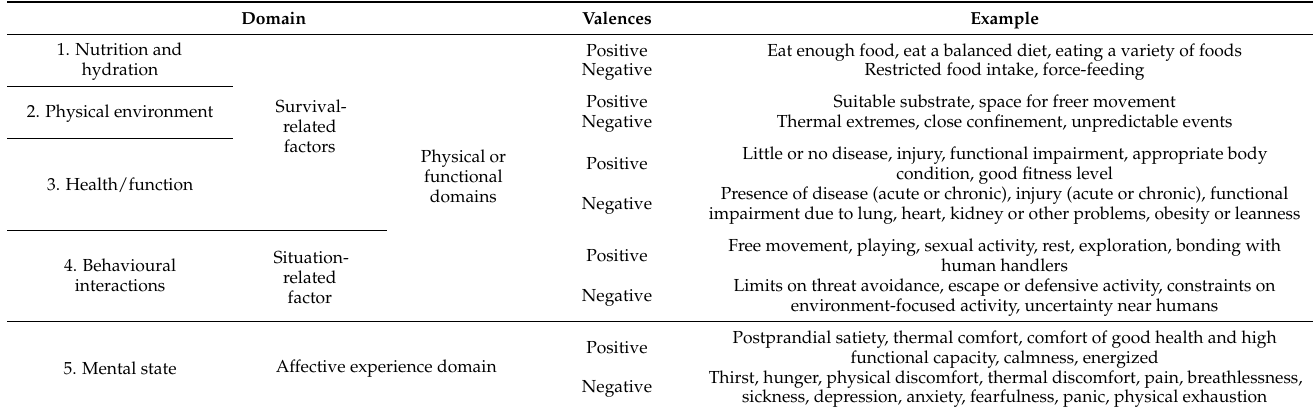
Table 1. Components of The Five Domains Model (modified from